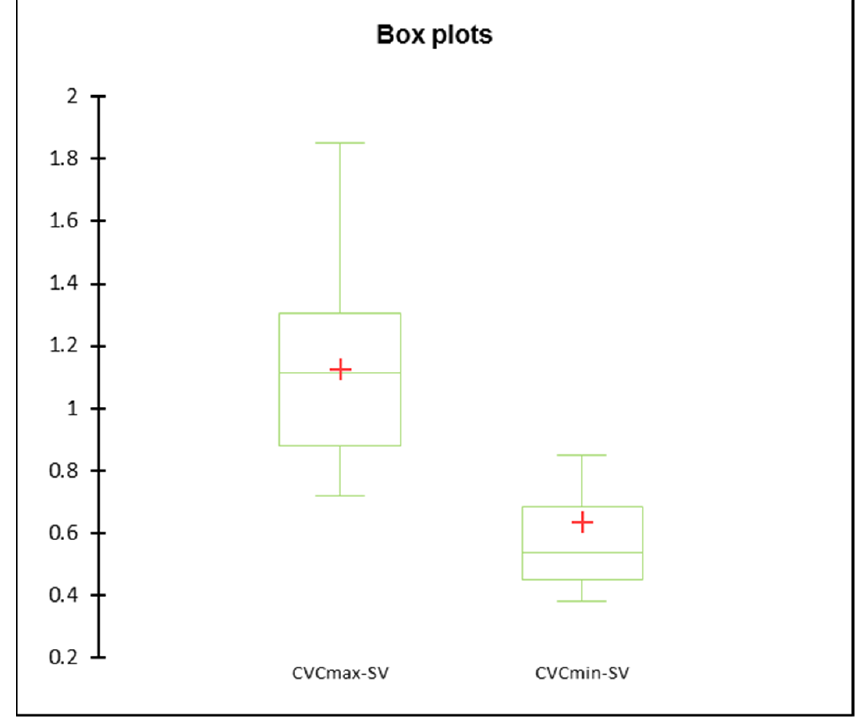
Figure 4. Box and whisker plots of the CVC measurements at the subxiphoid site when the CVC crossed the diaphragm. The CVC min is CVC minimal diameter and the CVC max is CVC maximal diameter measured.